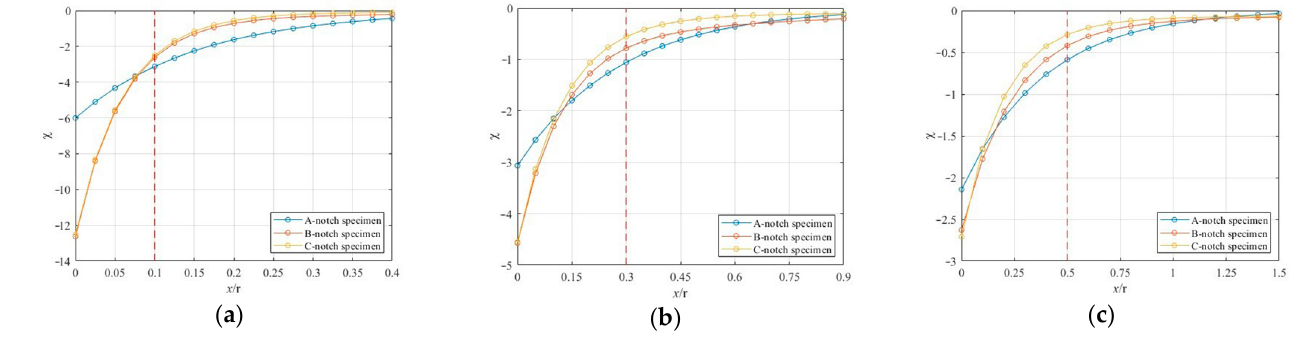
Figure 5. Notched specimen relative stress gradient ( a ) r = 0.2 mm; ( b ) r = 0.6 mm; ( c ) r = 1 mm (elastic–plastic conditions).